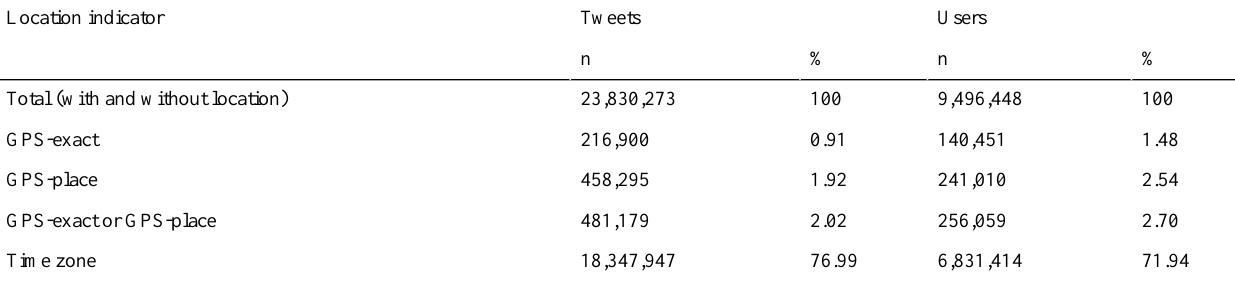
Table 1. Tweets and users providing location